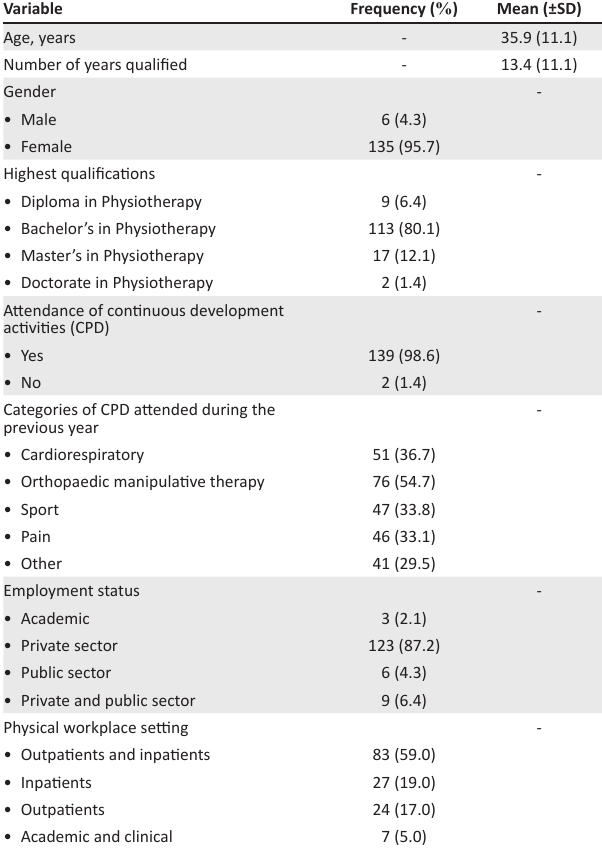
TABLE 1: Demographic profile of physiotherapists treating patients with a thoracotomy incision ( n = 141).